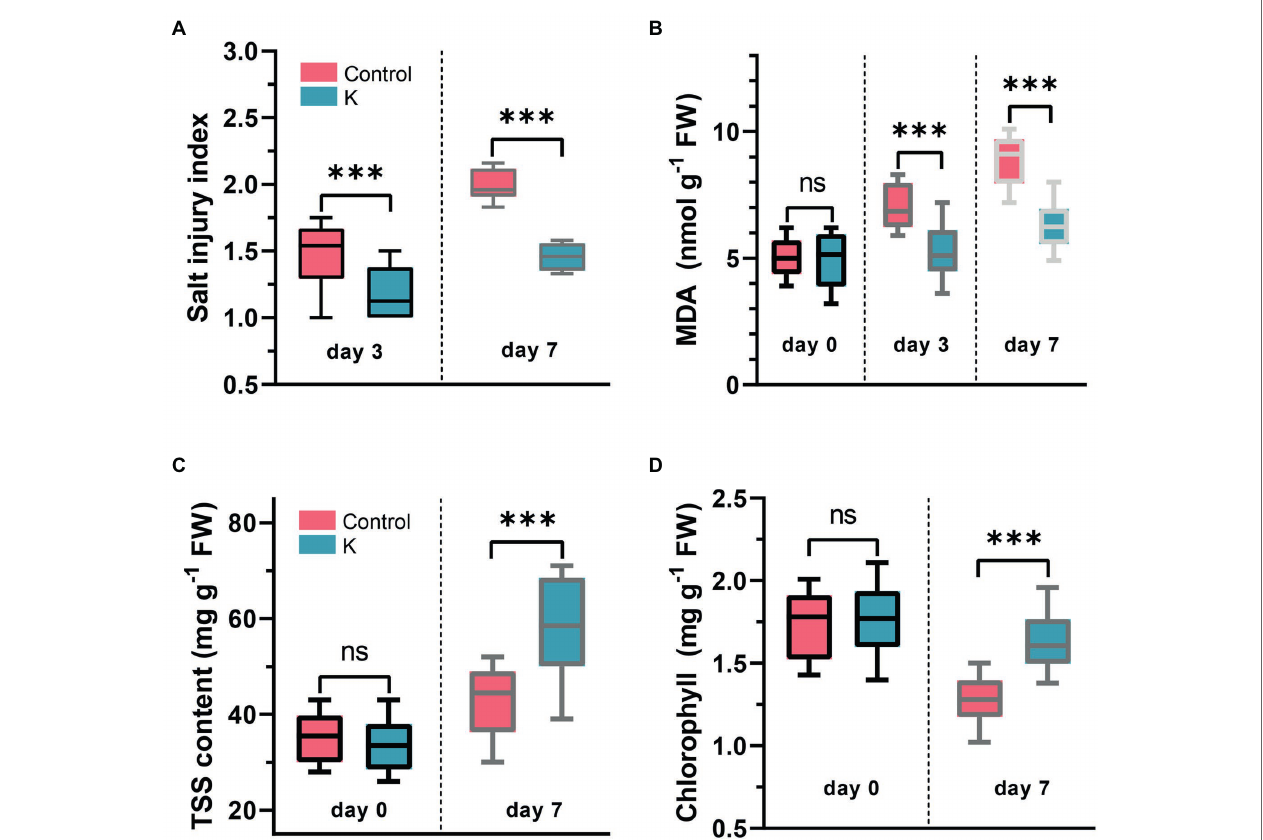
FIGURE 4 | Box plot showing Mucilaginibacter sp. K effects on salt injury index (A) , malondialdehyde (MDA) (B) , total soluble sugars (TSS) (C) , and chlorophyll content (D) in leaves of 14-day-old maize seedling (day 0) under salt stress (100 mM) for 3-7 days. The group median and interquartile range were displayed. Asterisks indicate the statistically significant differences compared to controls ( *** p <